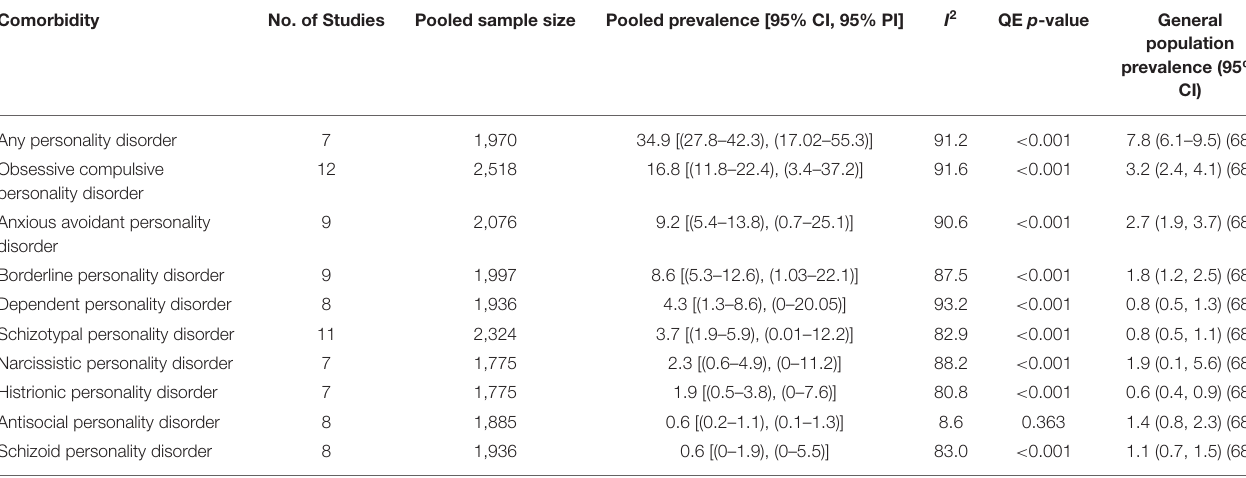
TABLE 2 | Pooled prevalence of personality disorder comorbidities among adults with obsessive compulsive disorder. Comorbidity No. of